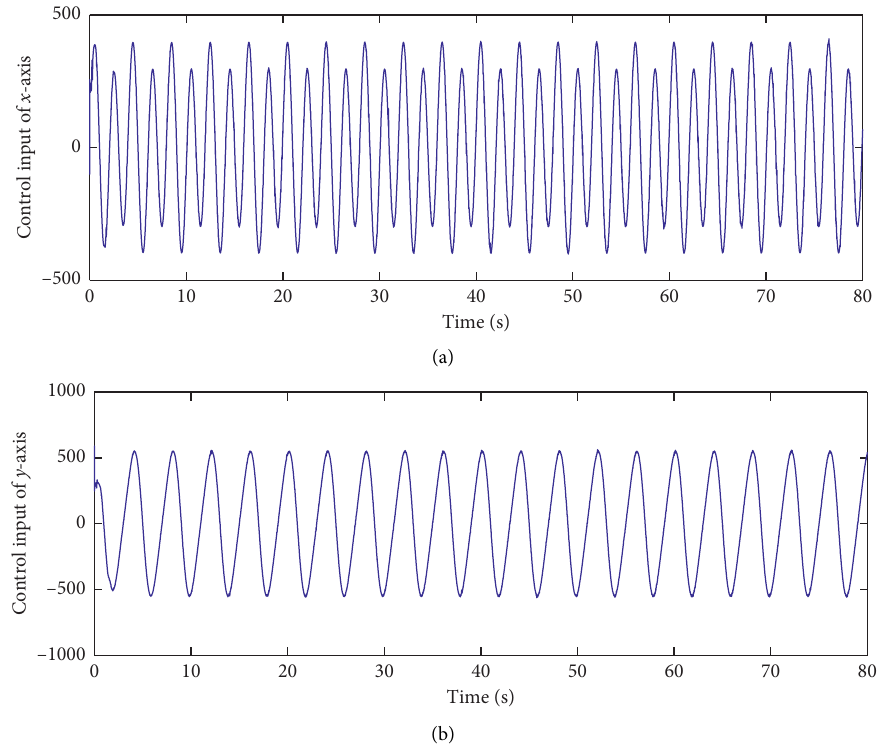
Figure 9: Control input signals using fractional fast TSMC.